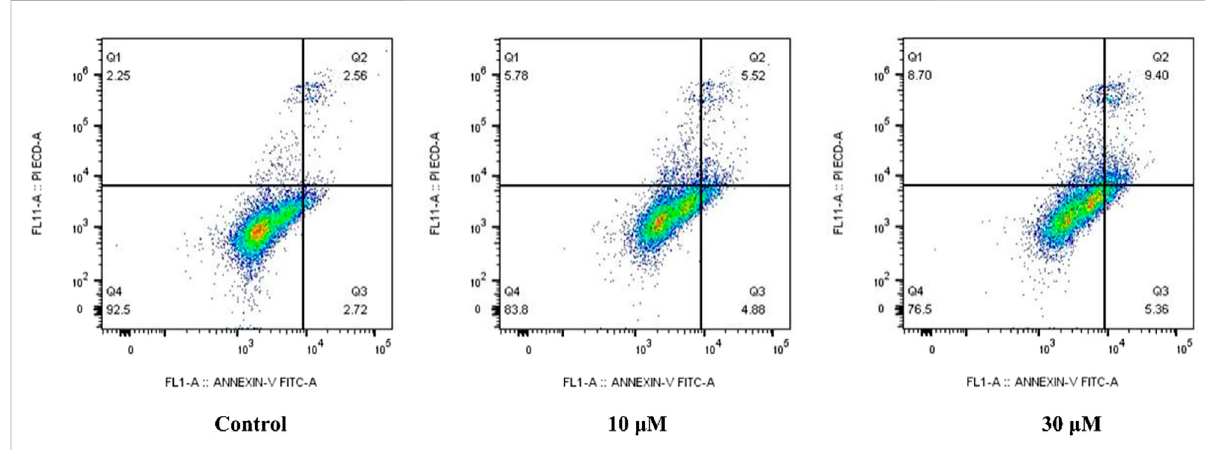
FIGURE 6 Compound E induced cell apoptosis in a concentration-dependent manner.